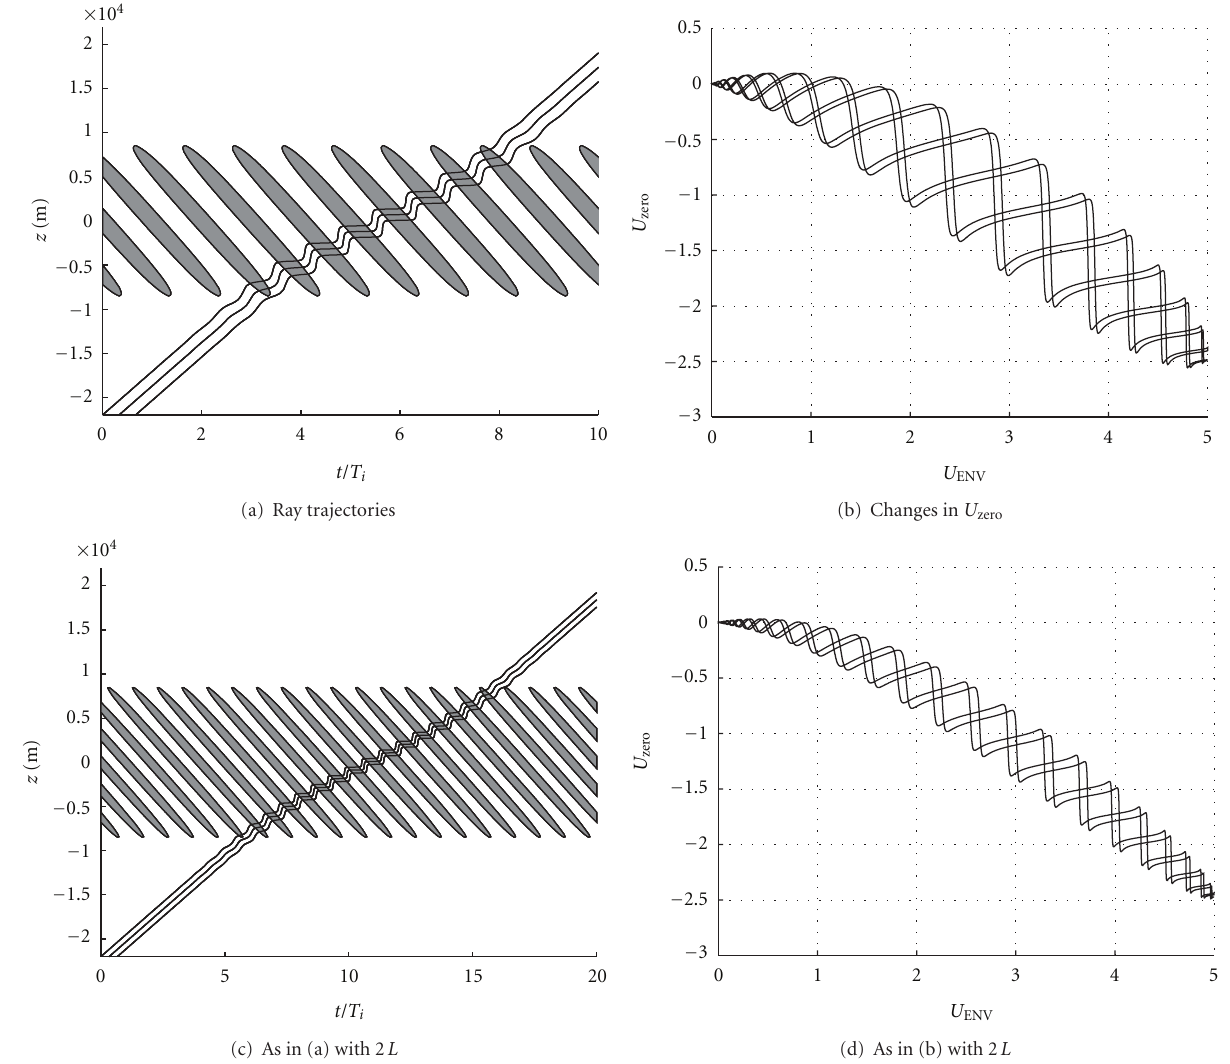
Figure 7: Estimate of U zero along rays due to short wave propagation through an enveloped inertia wave. In (a), the shaded regions represent horizontal velocities exceeding time-independent critical level velocity. In (b), the black lines show U zero for each ray, one as each ray propagates into the center of the envelope, and the other as each propagates out of the envelope. The line through the center of the oscillations shows the average U zero during propagation. It begins at zero and decreases toward the center of the envelope, then returns to zero as is exits the